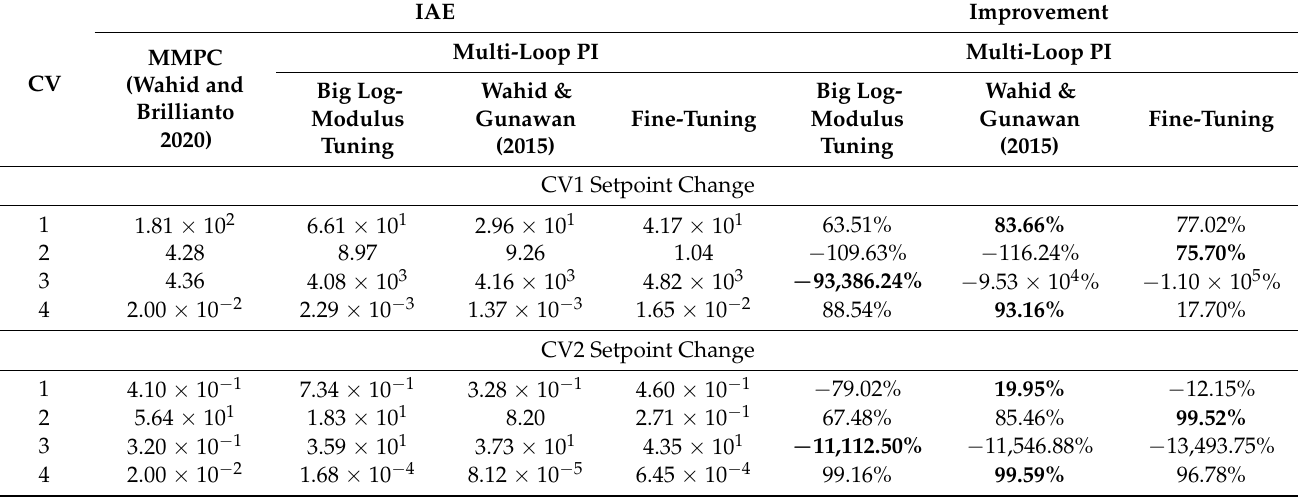
Figure 6. Responses against setpoint tracking using BLT, FT, and WG (top to bottom) in terms of ( a ) the vessel temperature of Column T-103 (CV1), ( b ) the temperature of the MeRecy stream (CV2), ( c ) the liquid percent level of Condenser T-103 (CV3), and ( d ) the total volume percent of T-103 (CV4). CV1 is colored blue, CV2 is colored yellow, CV3 is colored green, and CV4 is colored red. Step of CV1 is colored orange, Step of CV2 is colored purple, Step of CV3 is colored light blue, and Step of CV4 is colored blue. Table 12. IAE comparison of MMPC and multi-loop